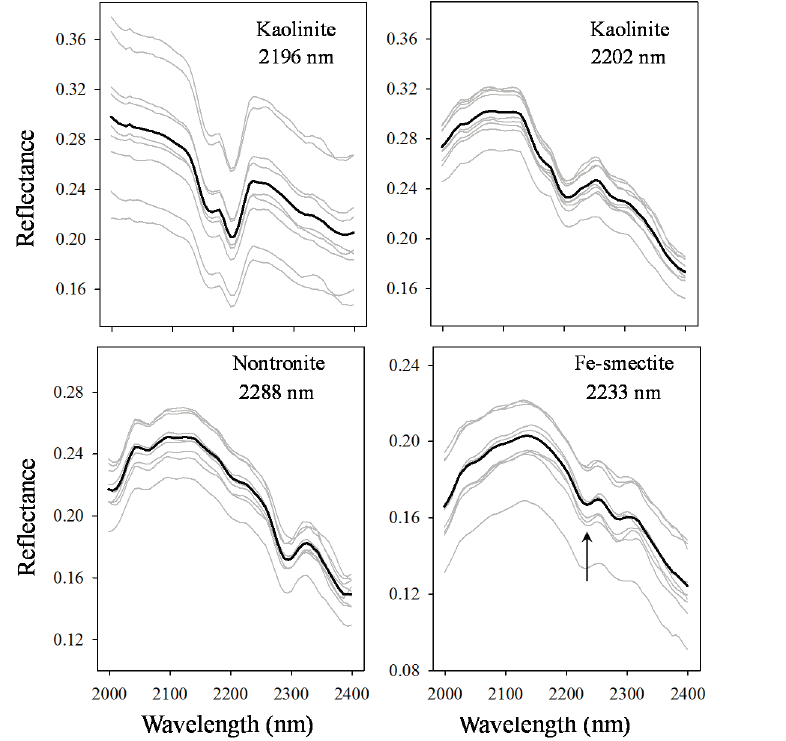
Figure 10. Single pixel spectra (grey lines) and their averages ( n = 9; black lines) of the 4 most frequently occurring absorption features found by AFE on the mine face: Kaolinite (2196 nm and 2202 nm), Nontronite (2288 nm) and Fe-smectite (2233 nm). Note that the deepest absorption for Fe-smectite is at 2233 nm after removal of the spectral continuum (indicated by